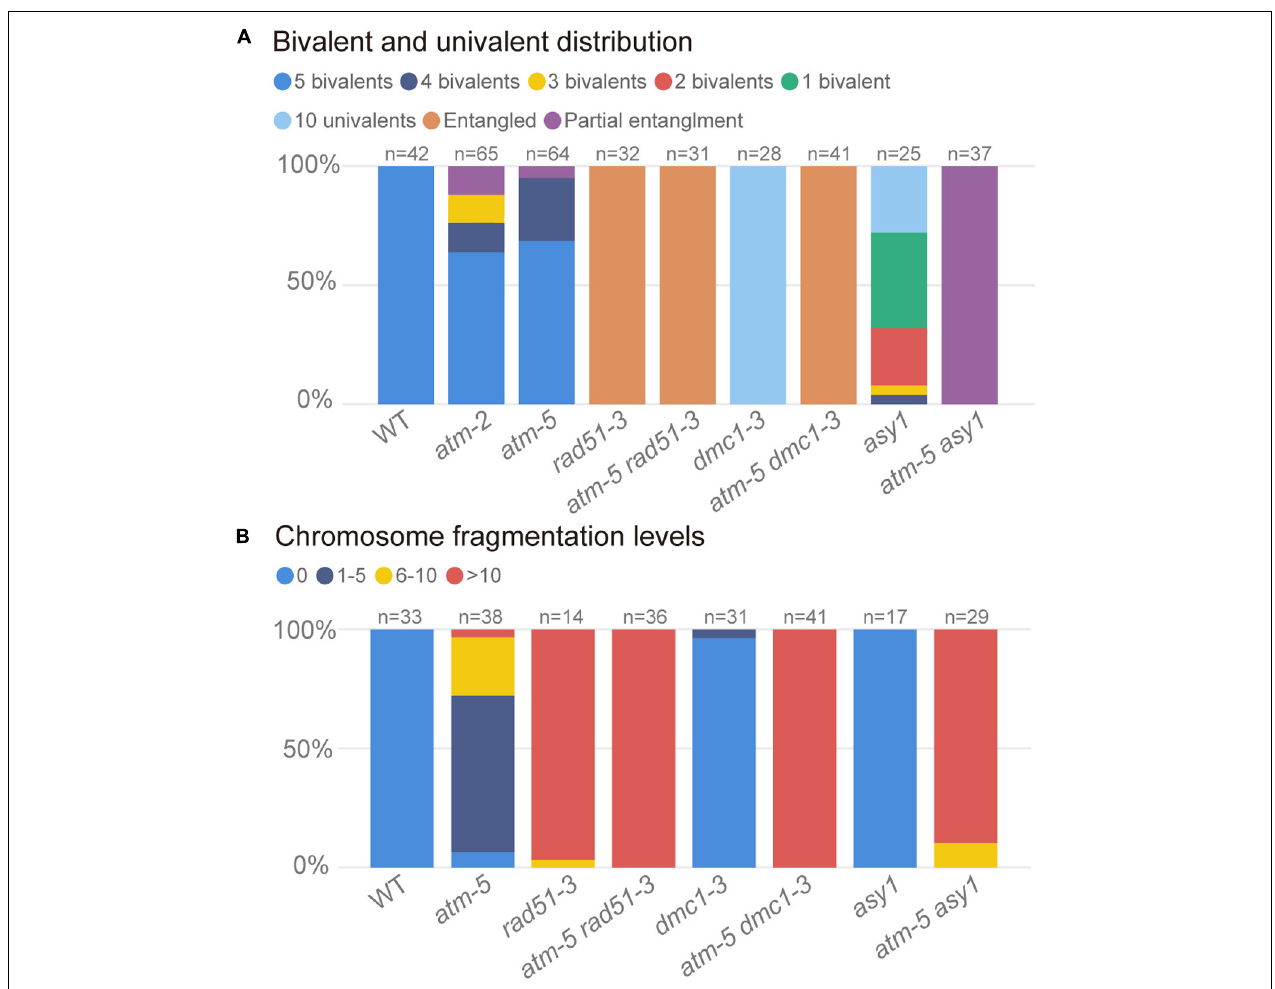
FIGURE 7 | Quantification of bivalents and chromosome fragments in different alleles. (A) Quantification of bivalent and univalent in different alleles. The number of bivalents or univalents in each allele was counted in the metaphase I cells. For those metaphase I cells contain entangled chromosomes were classified as entangled. For those metaphase I cells contain both entangled chromosomes and univalents were classified as univalents and entangled. For each allele, the counted cells are from about 20 plants. (B) Quantification of chromosome fragmentation levels in different alleles. For each allele, the anaphase II and telophase II cells were observed after DAPI stained chromosome spreads and centromeric FISH. DAPI stained bodies without centromere signal were taken as chromosome fragments. Chromosome fragmentation levels are divided into four categories: 0 (no chromosome fragmentation), 1–5 (1–5 fragments per cell), 6–10 (6–10 fragments per cell) and > 10 (more than 10 fragments per cell). For each allele, the counted cells are from about 12